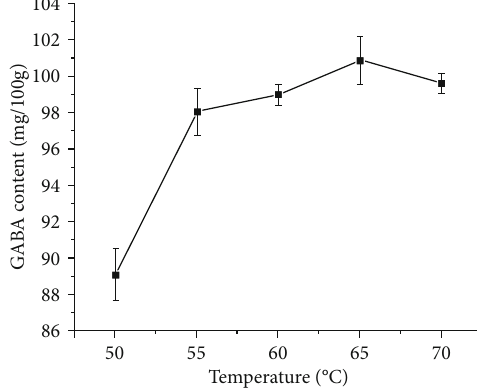
Figure 13: E ff ect of temperature on GABA content.